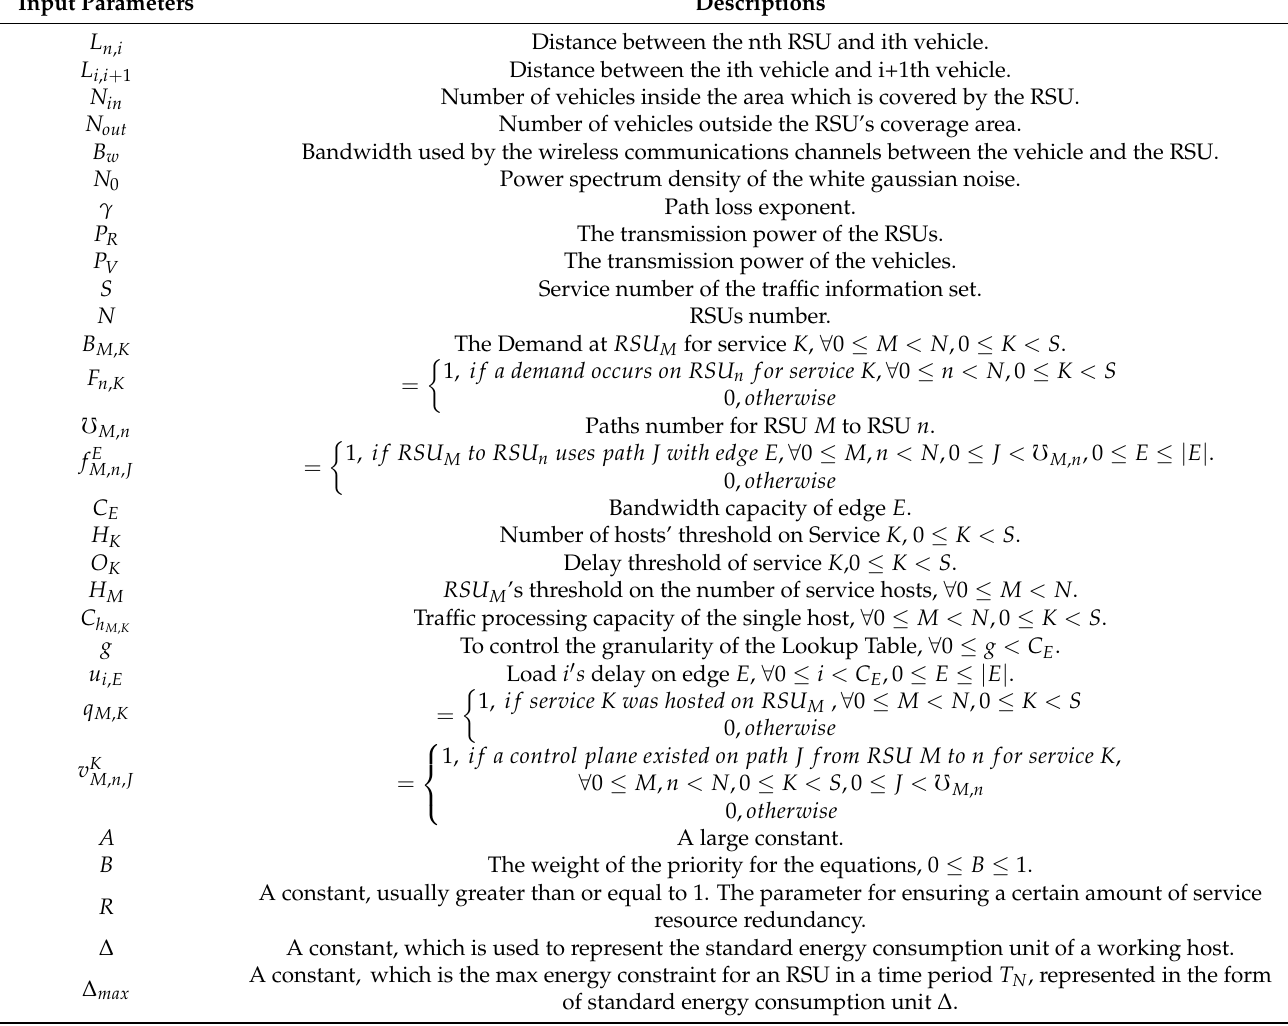
Table 1. Definitions for the communications demand